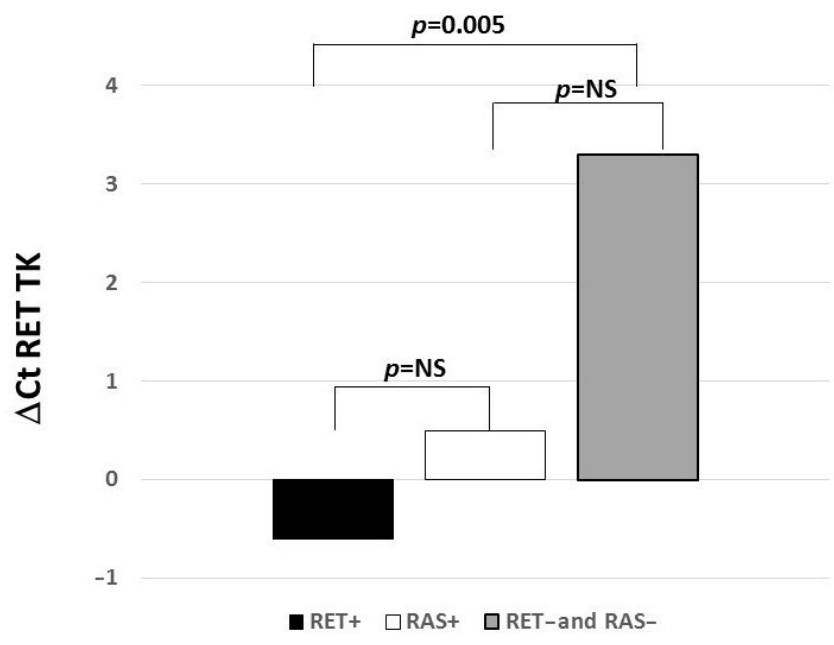
Figure 1. RET gene expression levels according to the somatic mutation profile. A statistically significant higher expression level was observed in RET +. Gene expression levels are reported as ∆ Ct ( ∆ Ct = Ct RET − Ct G6PD ) where Ct is the threshold cycle for qRT-PCR. The lowest is the ∆ Ct value, and the highest is the mRNA expression